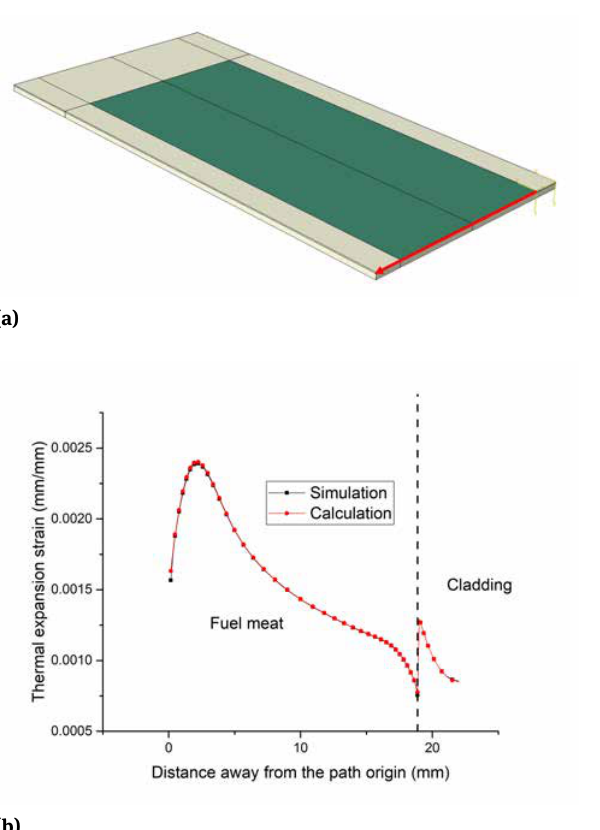
The heat flux obeys: